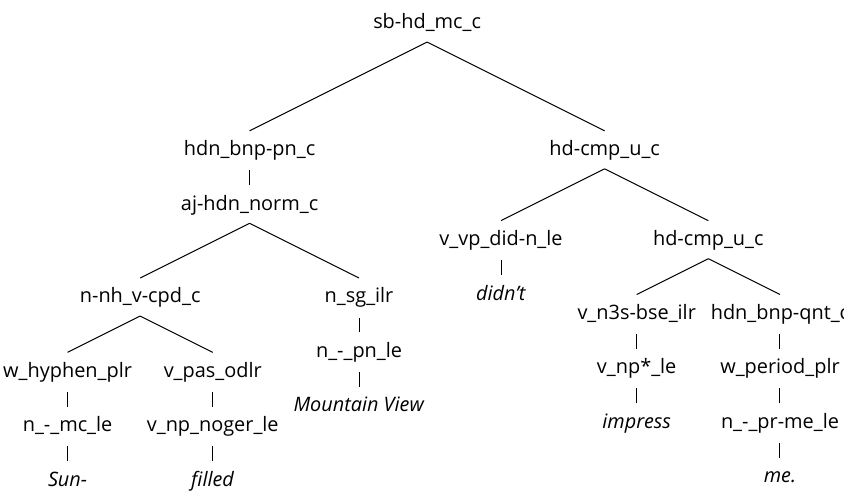
Figure 1: Sample HPSG derivation: construction identifiers label internal nodes, and lexical types the preterminals